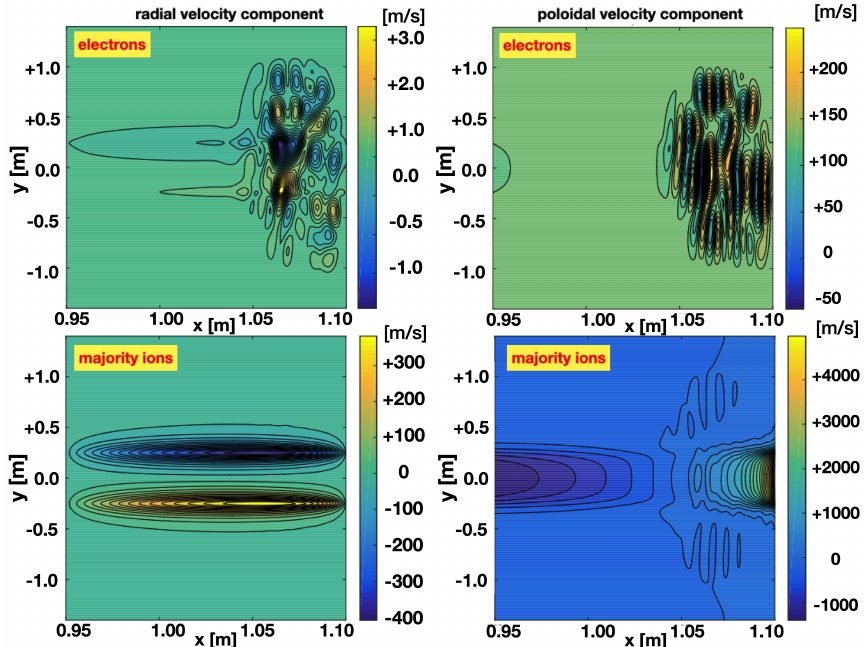
Figure 5. Electron ( top ) and deuteron ( bottom ) zero-order velocities corresponding to the electric field in the bottom of Figure